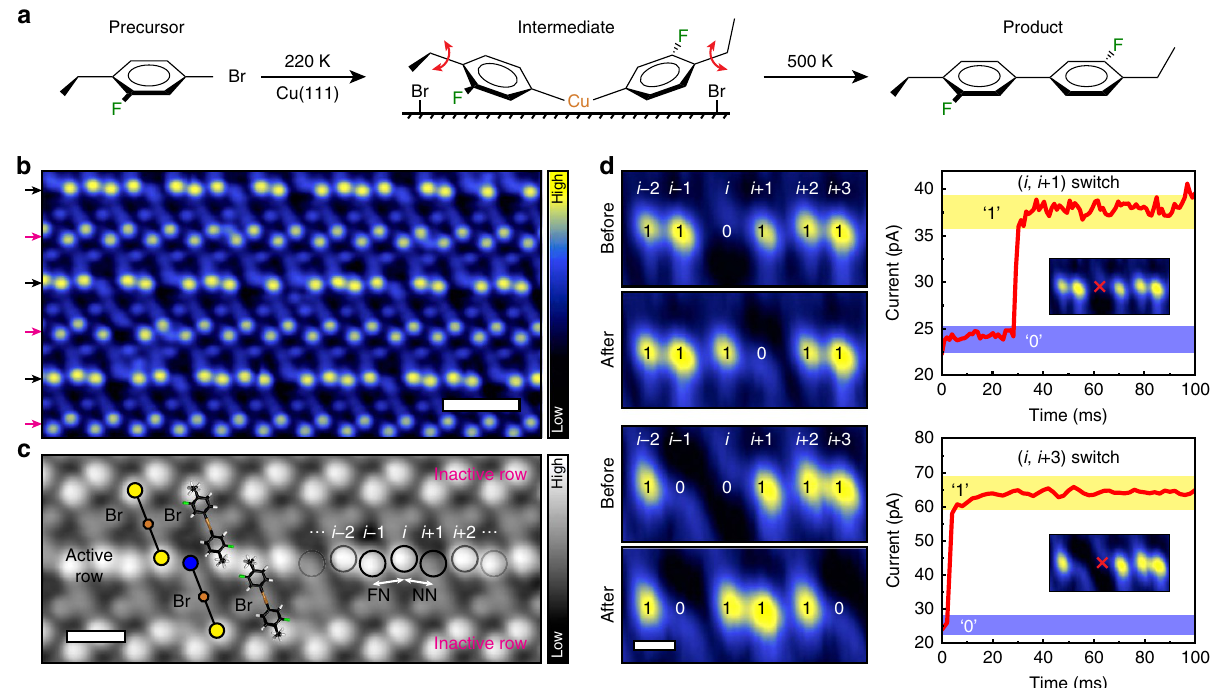
Figure 1 | Correlated switching in self-assembled molecular rotor crystals. ( a ) Surface-mediated Ullmann coupling reaction scheme. ( b ) STM image of a two-dimensional crystal composed of the reaction intermediate in which the ethyl rotors appear either as bright protrusions or depressions depending on their orientation. The reaction intermediates form an interlocked pattern and the ethyl rotors form active (exhibiting correlated switching; black arrows) and inactive rows (no switching; magenta arrows). Scale bar, 2nm. ( c ) Zoom in of the active row with both colour-coded and molecular overlays. Yellow and blue circles indicate the up and down configurations of the ethyl rotors, respectively. An example of ethyl rotor indexing is shown where i þ 1 and i (cid:2) 1 denote the NN and FN of rotor i , respectively. Scale bar, 1nm. ( d ) Same-pair ( i , i þ 1) and long-range ( i , i þ 3)-correlated switching observed when pulsing rotor i in the active row with the STM tip. The resultant current versus time traces are shown with the location of the STM tip pulses ( ± 50mV) marked with a red cross; scale bar, 0.5nm, and imaging performed at (cid:2) 10mV and